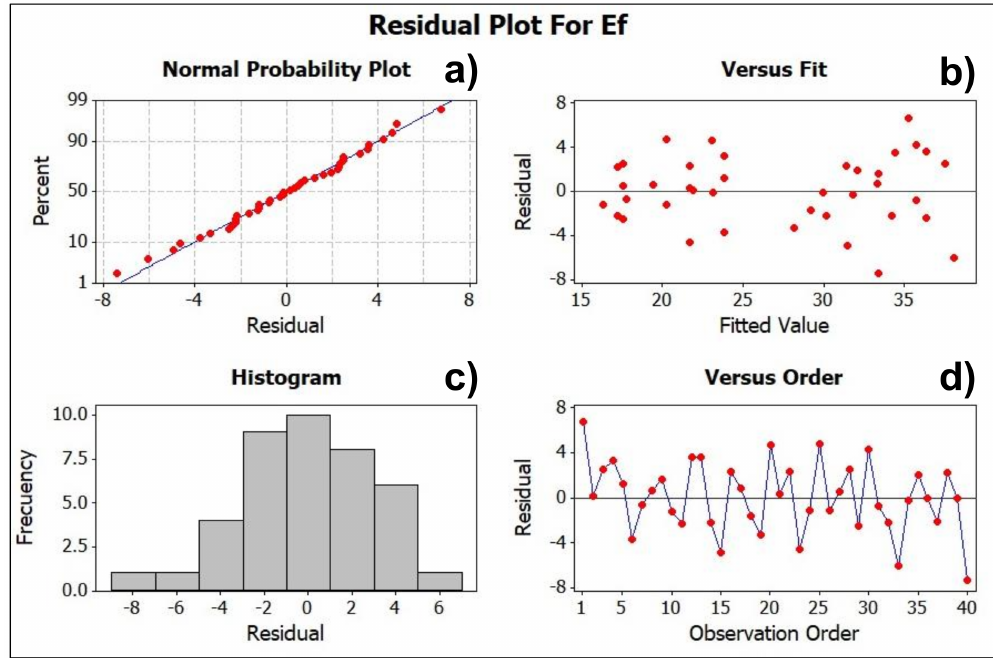
Figure 3. Residual plot for elongation to fracture (Ef): ( a ) normal probability, ( b ) versus fit, ( c ) histogram and ( d ) versus order.